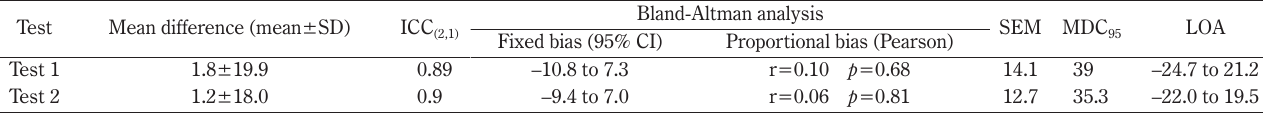
Figure 11 Comparison of isometric maximum torque estimates. Mann-Whitney U test. *p<0.05 Table 2 Reliability of each estimate of isometric maximum torque before and after modification of the leg extension